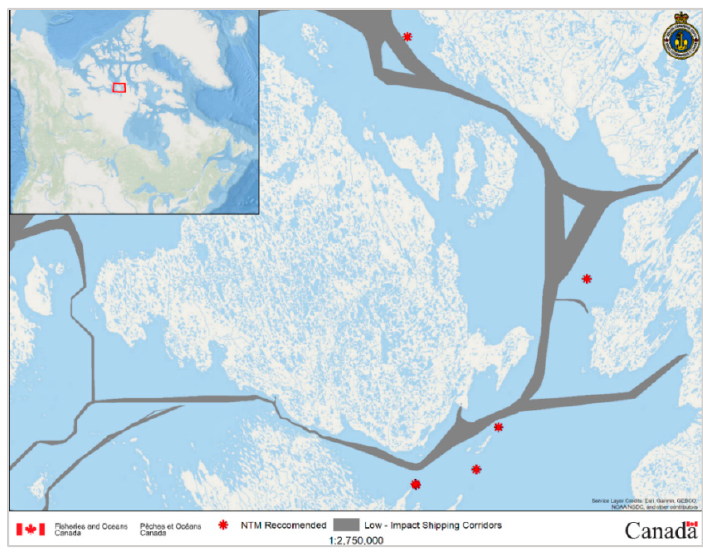
Figure 7. Example of notice to mariners (NTMs) issued by Canadian Hydrographic Service (CHS).